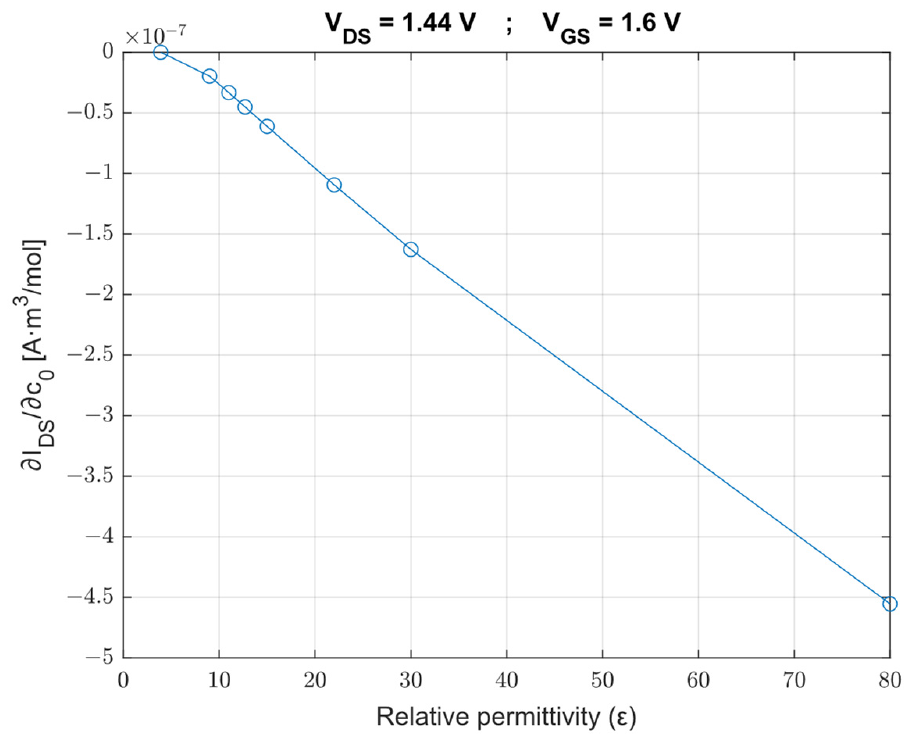
Figure 4. Drain-source current variation for two concentration values as a function of the high -k oxide used as an insulating layer.